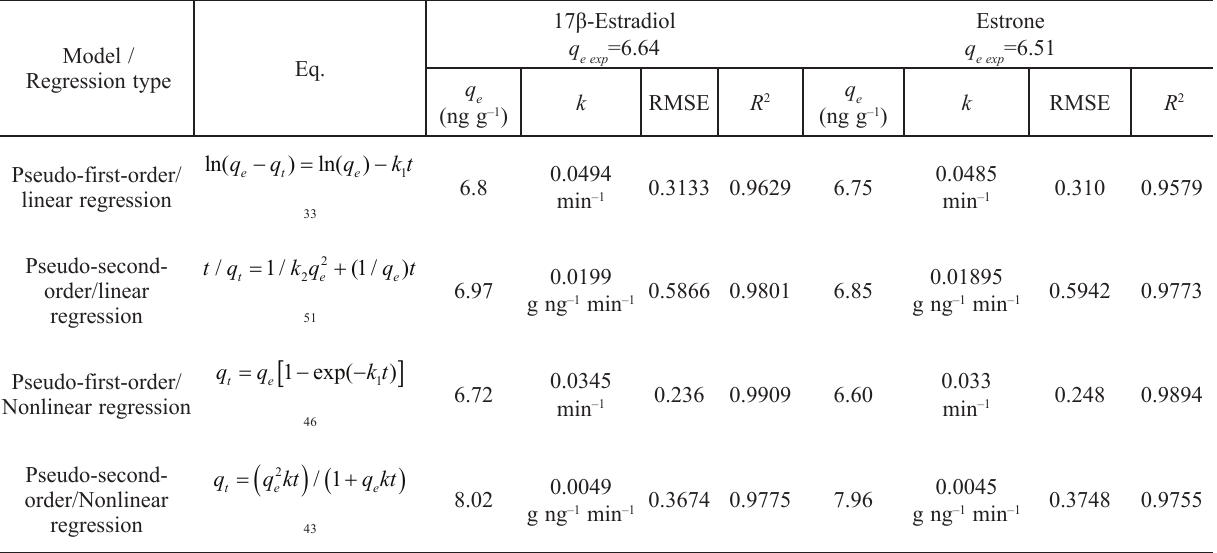
Table 2 – Results of adsorption kinetic models of E2 and E1 hormones on rice husk silica (adsorbent dosage of 1.5 g L –1 , pH of 4, and 10 ng L –1 concentration of E2 and